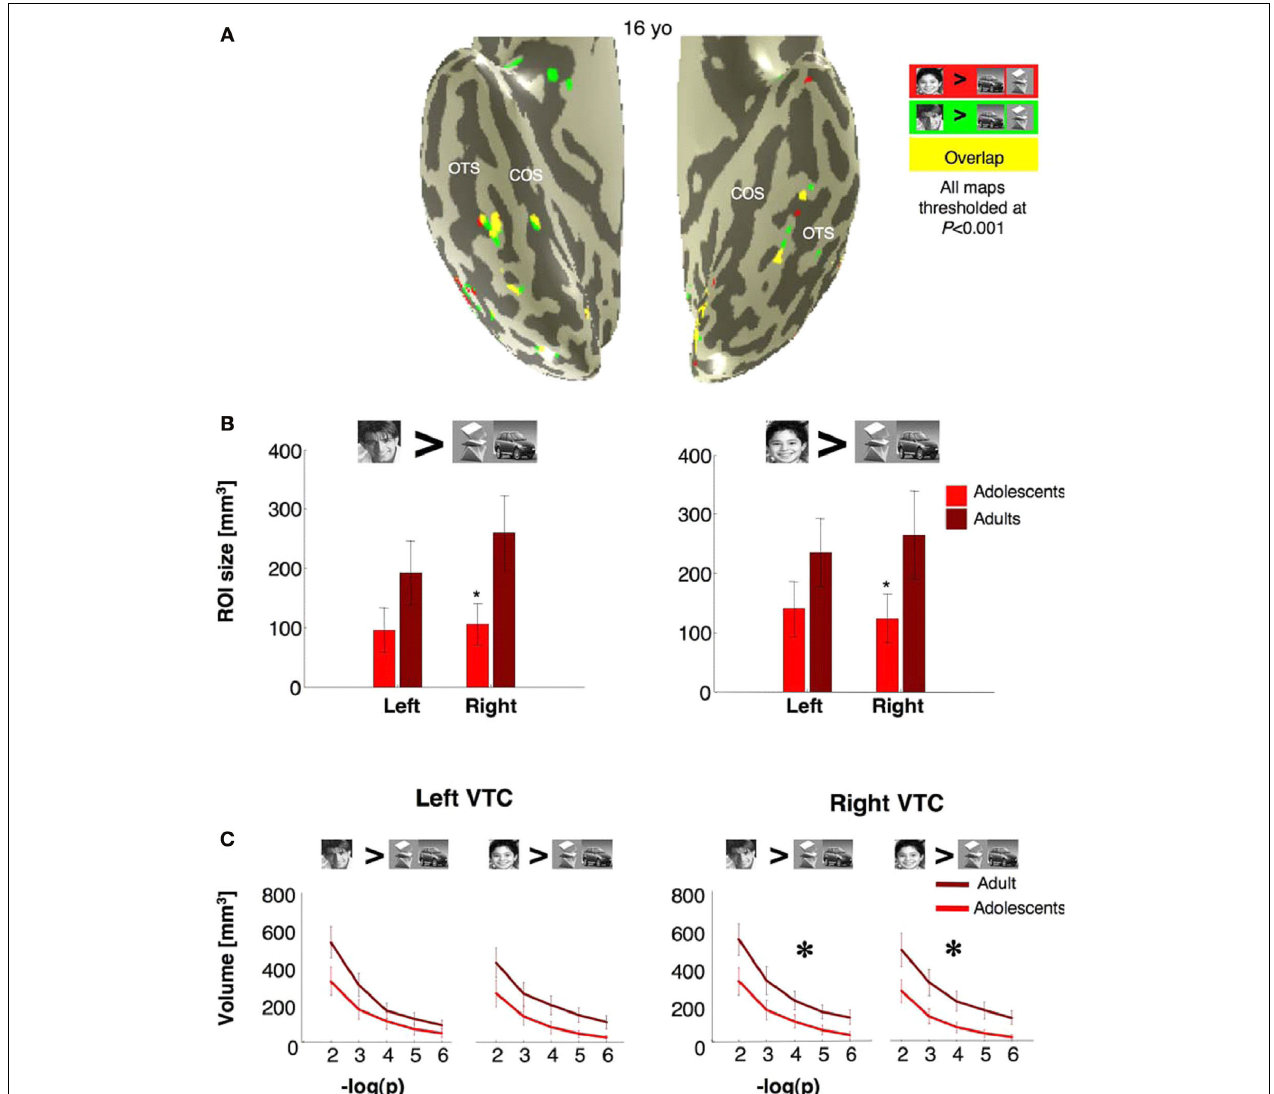
FIGURE 6 | Volume of face selective activations defi ned using either man or boy faces. (A) Activation maps for boy selective voxels ( boy faces > cars and abstract objects, P < 10 –3 ), red, man selective voxels ( man faces > cars and abstract objects, P < 10 – 3 ), green, and overlapping voxels (yellow). Data are shown for a representative adolescent brain. (B) Average volume of the cluster of voxels defi ned by the same contrasts as in (A) . Error bars show group SEM.